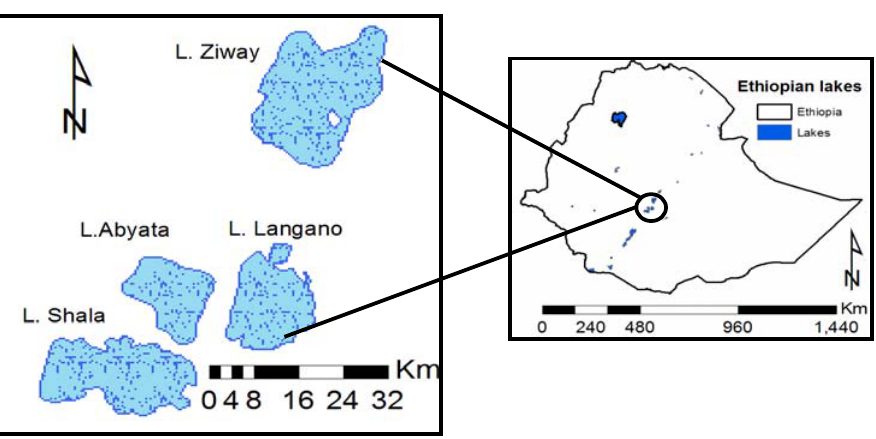
Figure 5. Ethiopian Rift valley lakes.